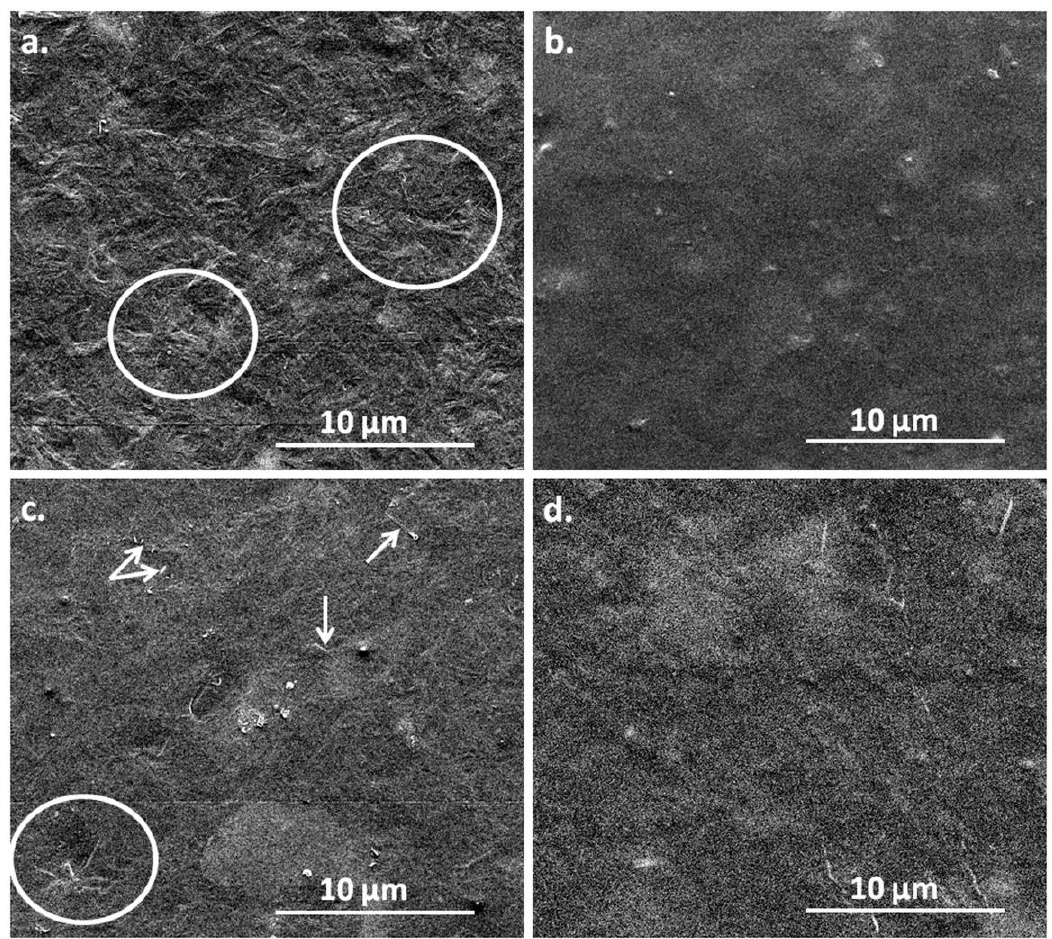
Figure 10. SEM images of PHB and PHB ‒ 5BC before ( a , c ) and after ( b , d ) the plasma treatment.